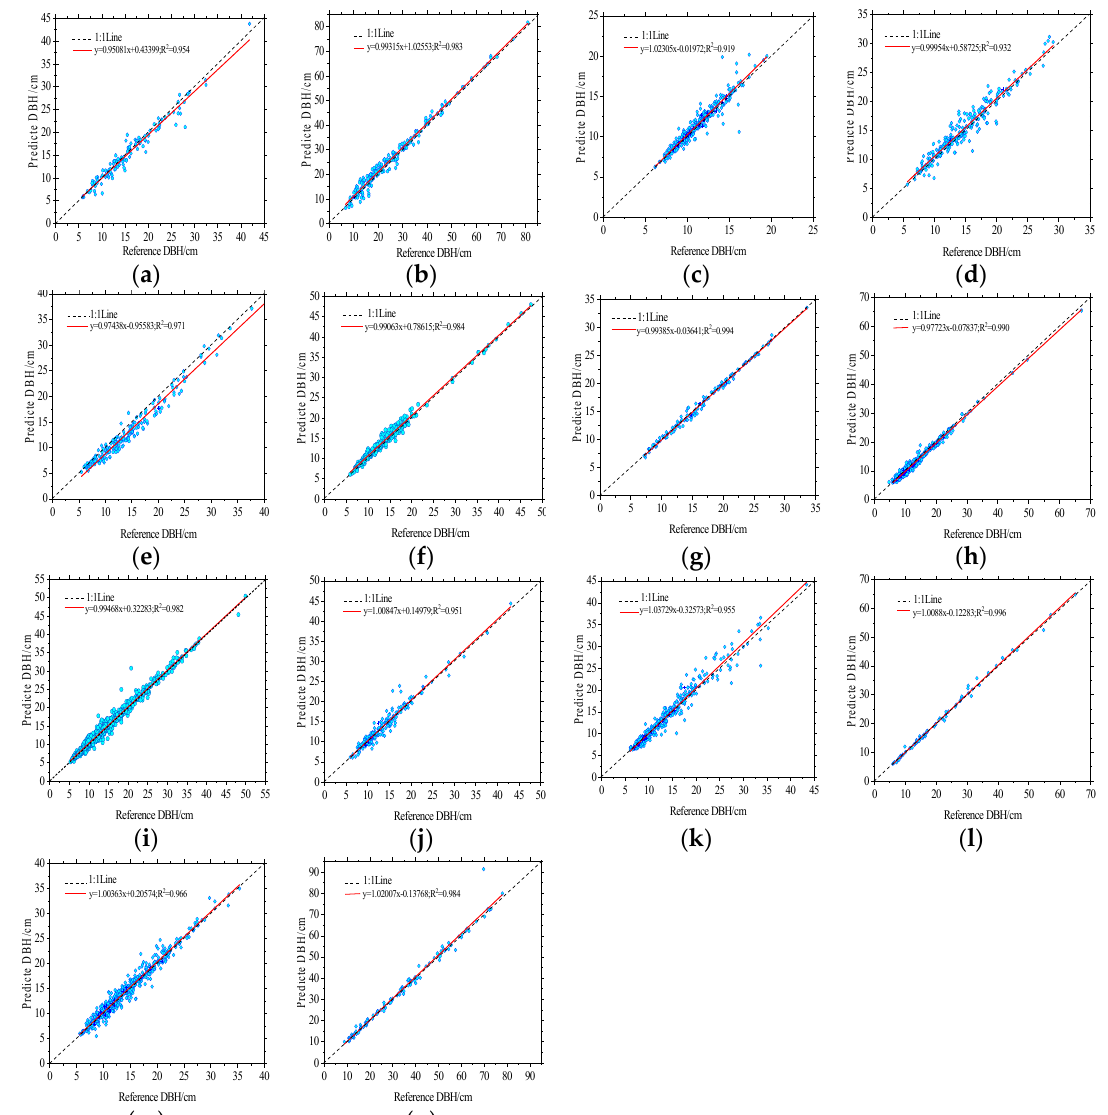
Figure 2. Fitting curve of the DBH between the predicted and actual values. The names of the tree species are as follows: ( a ): Pinus massoniana Lamb.; ( b ): Abies fabri (Mast.) Craib; ( c ): Platycladus orientalis (L.) Franco; ( d ): Cunninghamia lanceolata ; ( e ): Larix gmelinii (Ruprecht) Kuzeneva; ( f ): Larix principis-rupprechtii ; ( g ): Picea asperata Mast; ( h ): Quercus spp.; ( i ): Pinus tabuliformis Carrière; ( j ): Betula platyphylla Suk.; ( k ): Populus L.; ( l ): Picea likiangensis ; ( m ): Pinus yunnanensis ; and ( n ): Abies georgei Orr.